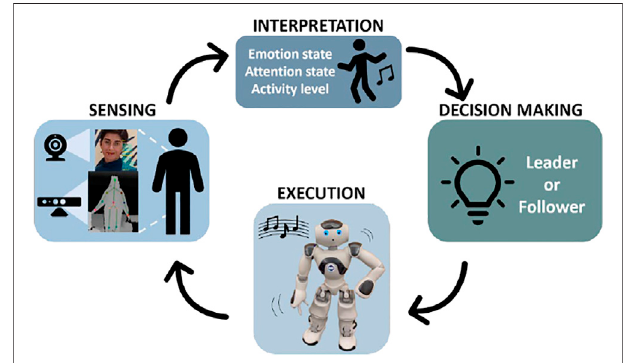
FIGURE 1 | An overview of the control architecture for our largely autonomous child-robot dance interaction. Our system implements a cycle where it senses behavioral cues from a user, interprets these to determine user engagement, decides a suitable role for the robot to assume next, and then executes the selected robot action (Written informed consent was obtained from the individual(s) AND/OR minor(s) ’ legal guardian.).